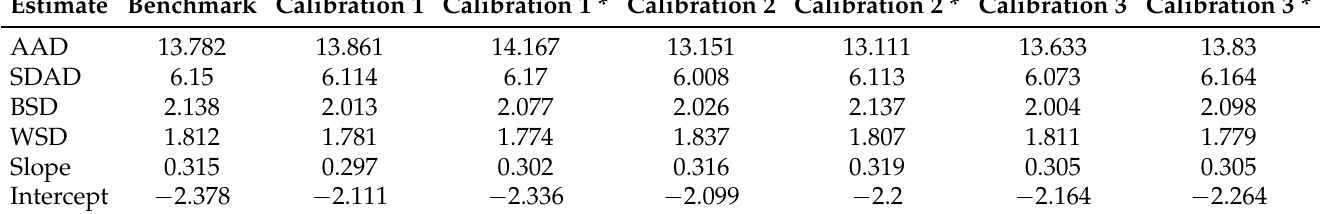
Table 1. Mean values for estimates of age-mixing patterns in sexual partnerships from the master model and after calibration with features from HIV epidemiology and sexual behaviour (Calibration 1), phylogenetic tree (Calibration 2), and a combination of the two types of features (Calibration 3).